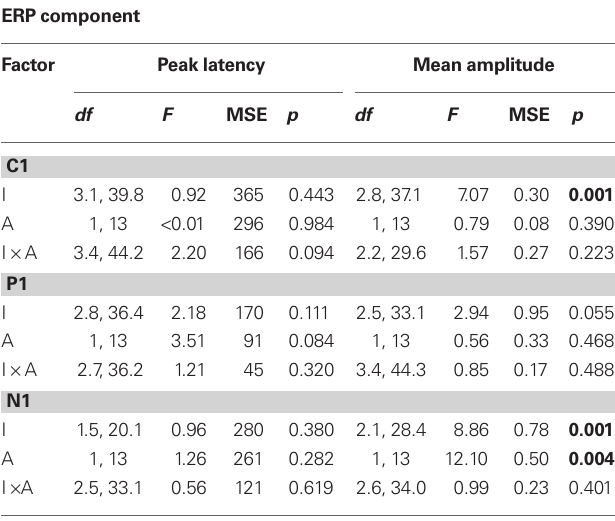
Table 1 | Summary of separate ANOVAs for peak latency and mean amplitude for visual C1, P1, and N1 components across parietal– occipital (PO3, POz, PO4, Oz)